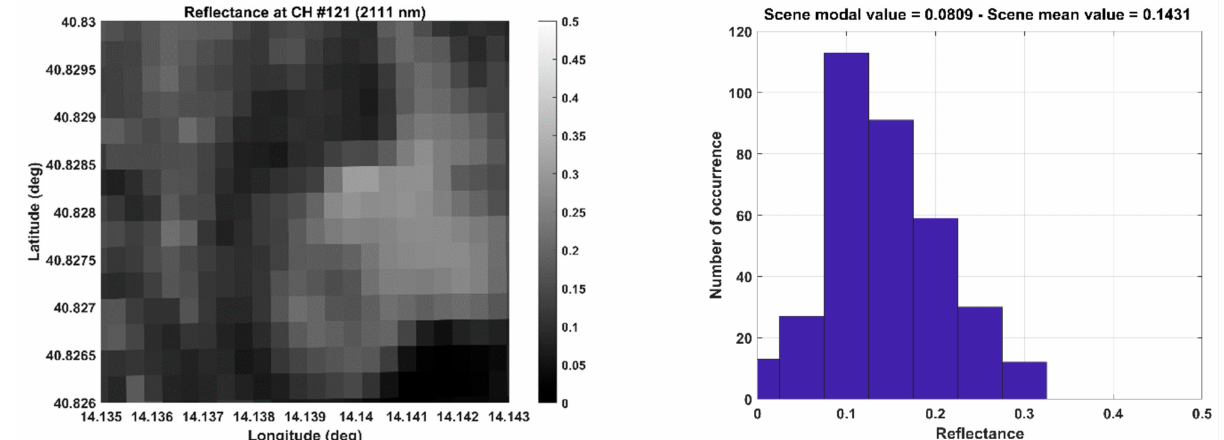
Figure 12. Reflectance from PRISMA L2D data product on